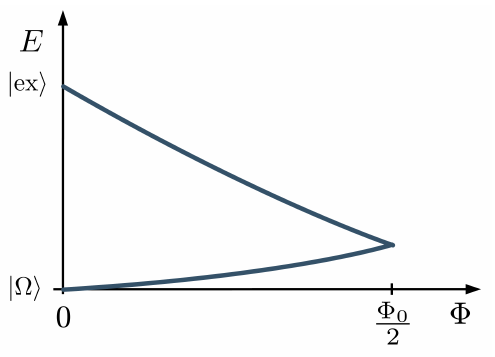
Figure 20: Energy levels of the ground state and an excited state as a function of the flux inserted, showing the Kramers degeneracy at half flux